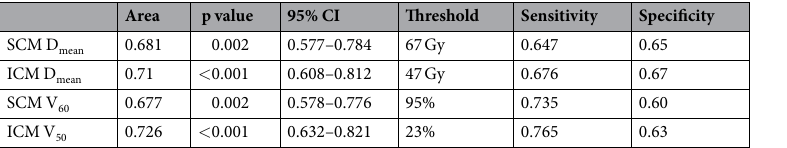
Area p value 95% CI